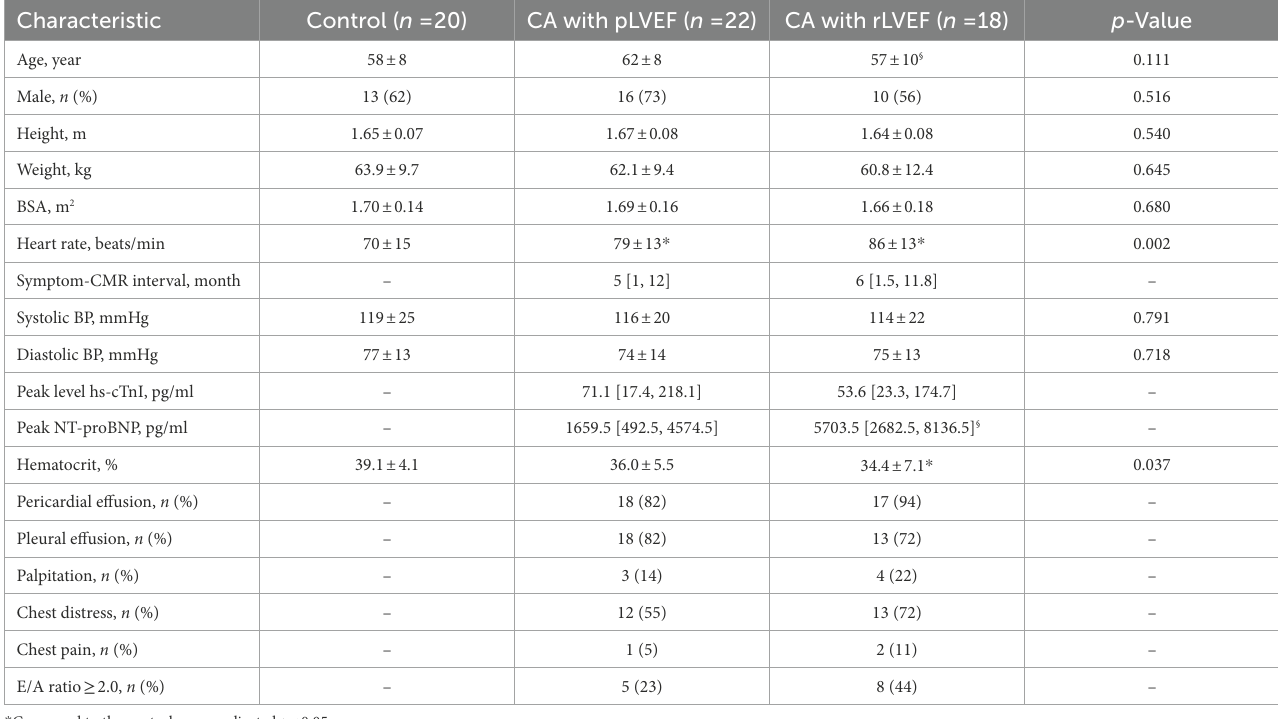
TABLE 1 Baseline characteristics of 40 CA patients and 20 healthy controls.